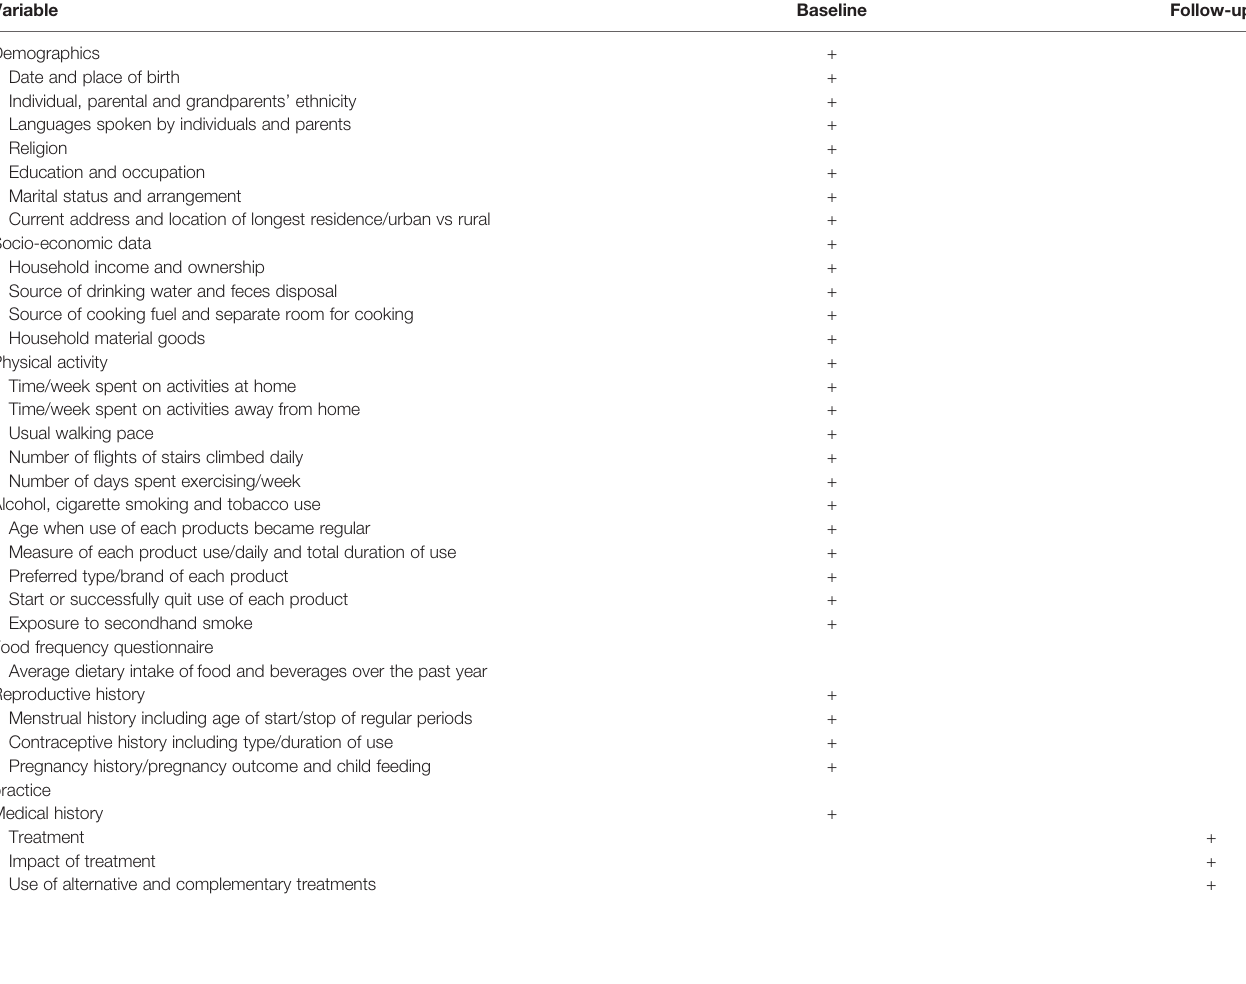
TABLE 1 | Data collected by